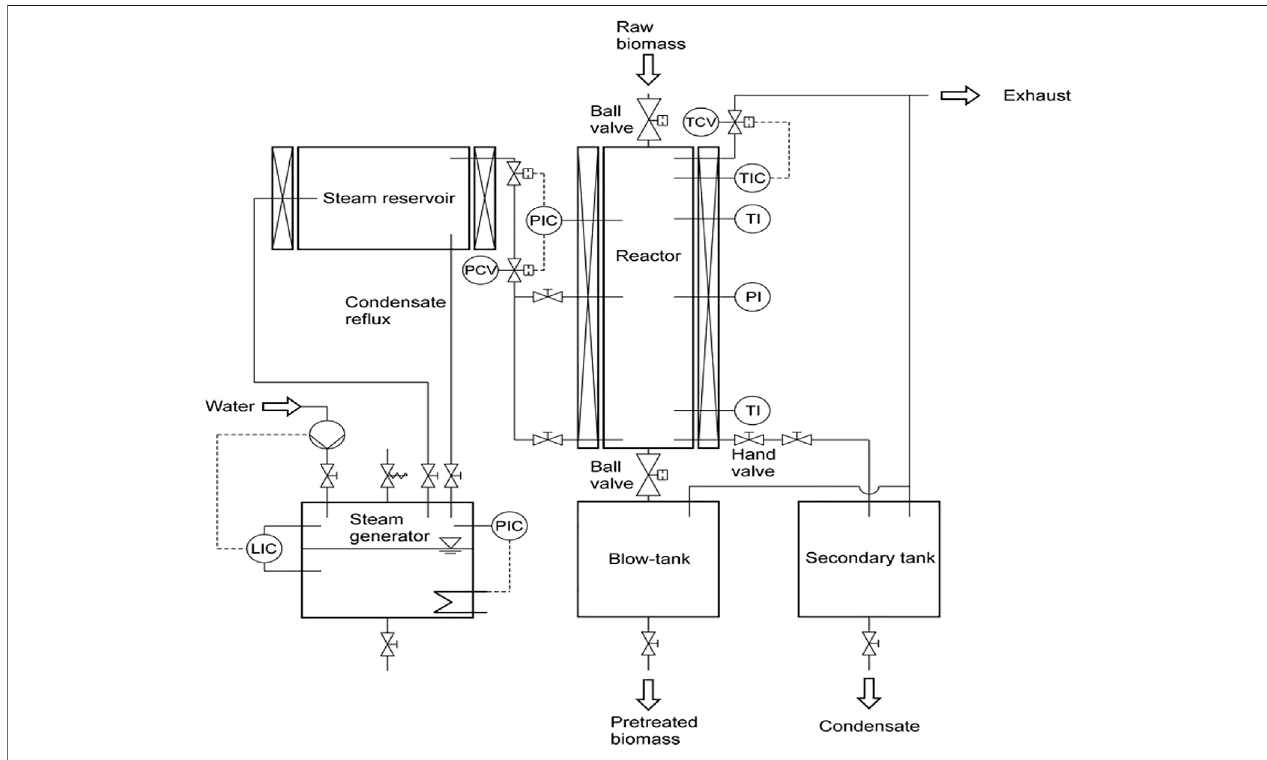
FIGURE 3 | Description of steam explosion pretreatment system (Pielhop et al., 2016).